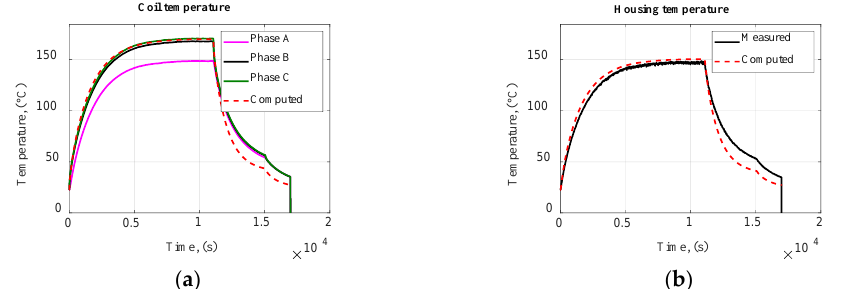
Figure 8. Measured and computed temperatures in the three phases ( a ) and in the housing ( b ) for the long-time pulse test in configuration A.